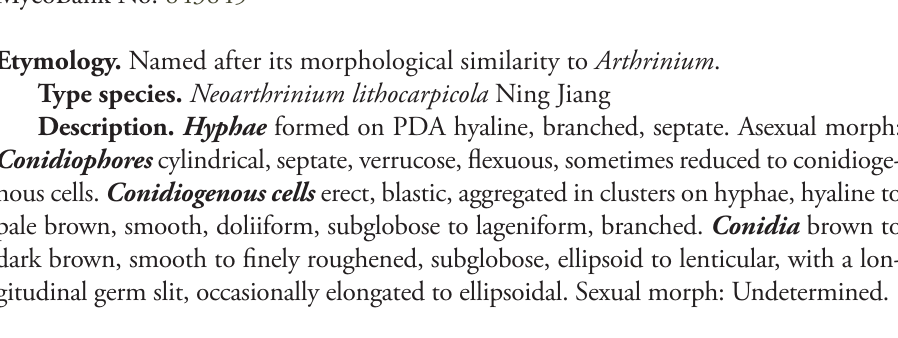
Fig. 2 Etymology. Named for its host genus “ Lithocarpus ” and “ -cola ” = inhabiting. Description. Hyphae 1.5–4.5 μm diam., hyaline, branched, septate. Asexual morph: Conidiophores cylindrical, septate, verrucose, flexuous, sometimes reduced to conidiogenous cells. Conidiogenous cells erect, blastic, aggregated in clusters on hyphae, hyaline to pale brown, smooth, globose to subglobose, branched, (4–)5.5– 8 × 2.5–3.5(–4) μm, mean ± SD = 6.6 ± 1.3 × 3.1 ± 0.4 μm, n = 50. Conidia brown to dark brown, smooth to finely roughened, subglobose to lenticular, with a longitudinal germ slit, occasionally elongated to ellipsoidal, (5–)6–8(–8.5) × (4.5–)5– 5.5(–6) μm, mean ± SD = 7 ± 0.8 × 5.3 ± 0.5 μm, L/W = 1.1–1.8, n = 50. Sexual morph: